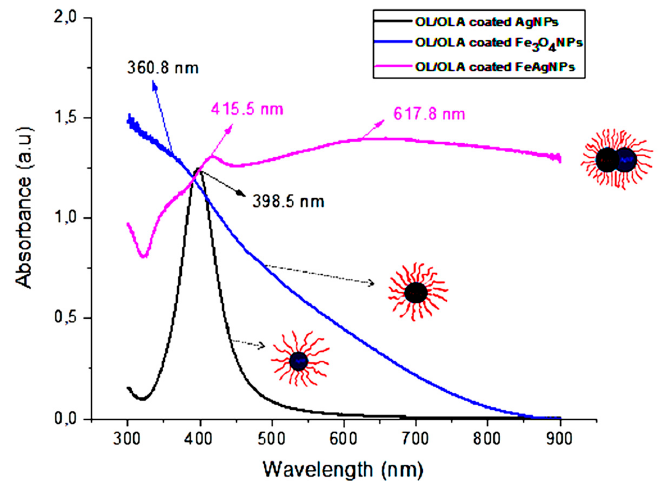
Figure 2. UV-visible absorption spectra of the OL/OLA coated Fe 3 O 4 NPs, PVP coated Ag NPs and OL/OLA coated FeAg NPs hybrid nanoparticles dispersed in hexane.